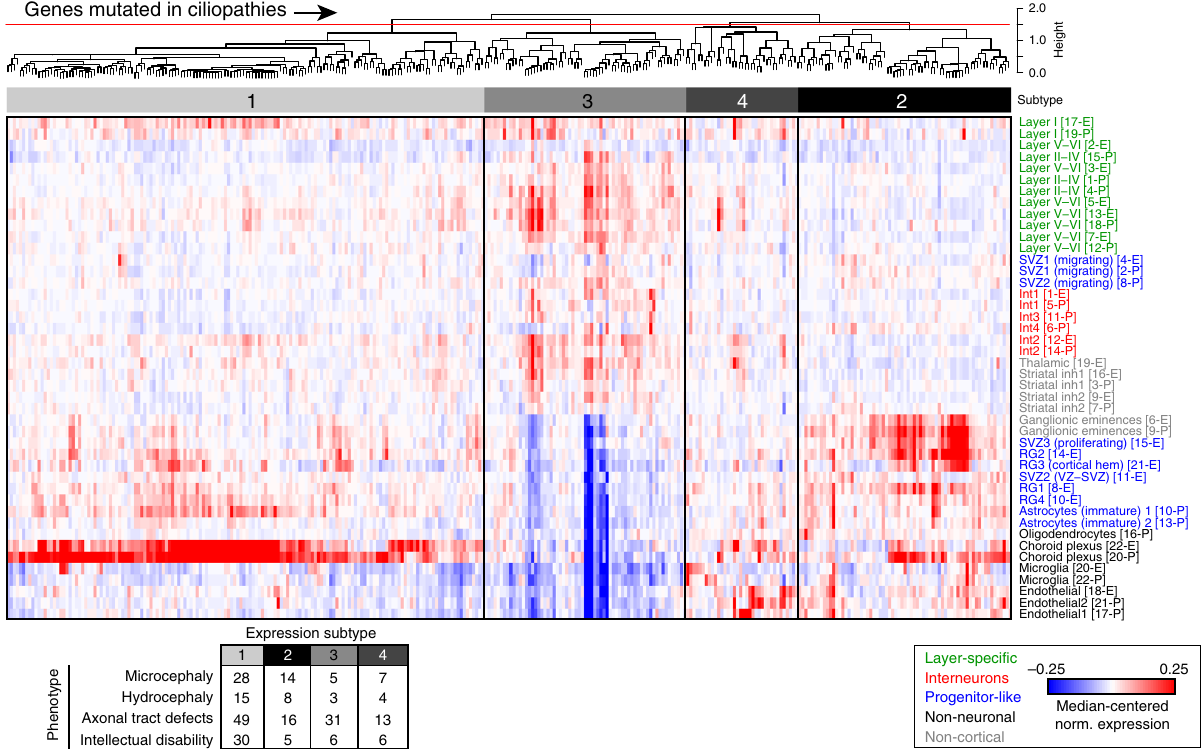
Fig. 4 Putative ciliopathy disease subtypes associate with clinical phenotypes. Normalized expression values for genes mutated in ciliopathies were hierarchically clustered, and the gene dendrogram (Pearson correlation) was cut at a set height (red line) to identify clusters of genes with similar cell- type- and age-speci fi c expression pro fi les. Counts indicating how many genes within a given subtype associated with a speci fi c clinical phenotype are provided as a table. Median-centered normalized expression values are depicted from blue ( – 0.25) to white (0.0) to red